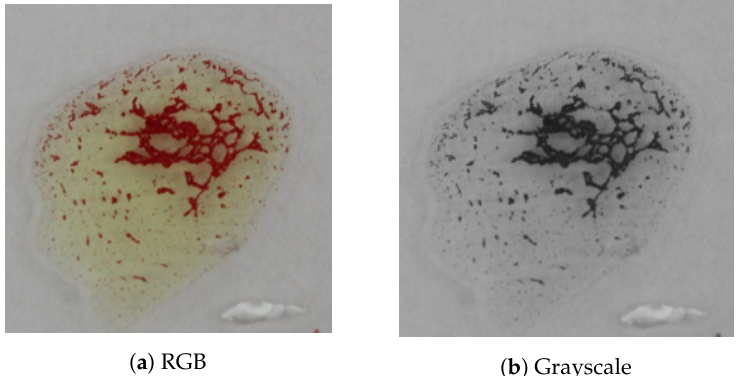
Figure 13. The referenced agglutination image used in the matching